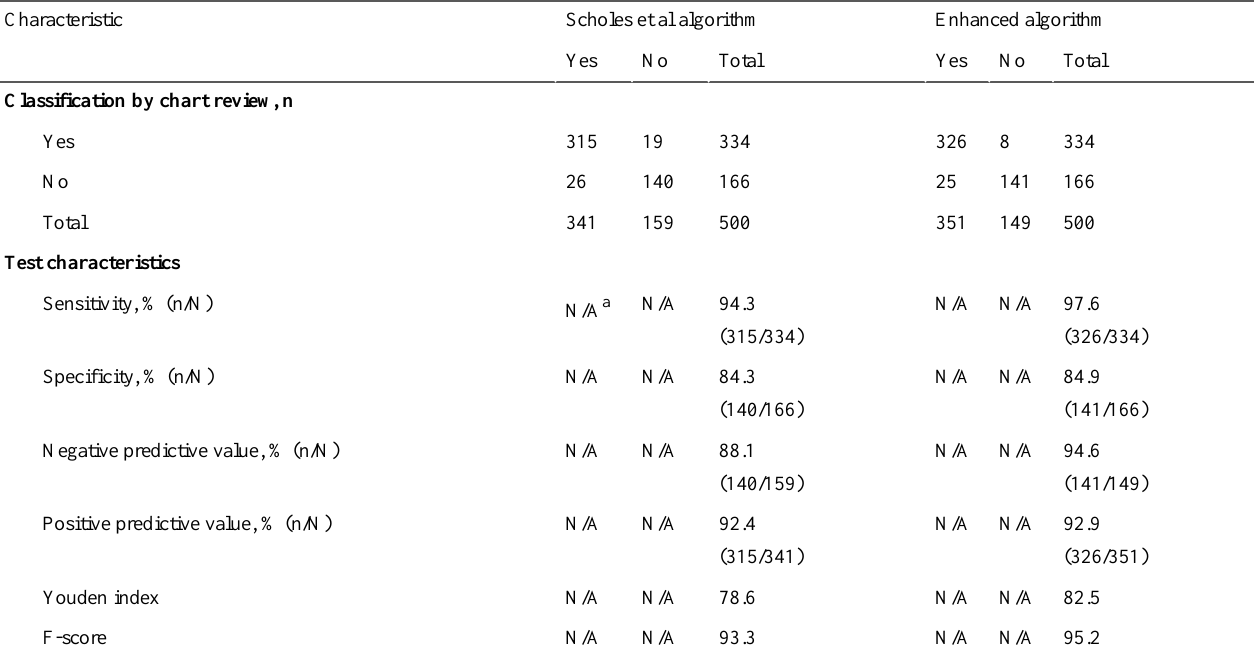
Table 2. Ectopic pregnancy ascertainment performance of the Scholes et al and enhanced ectopic pregnancy algorithms.